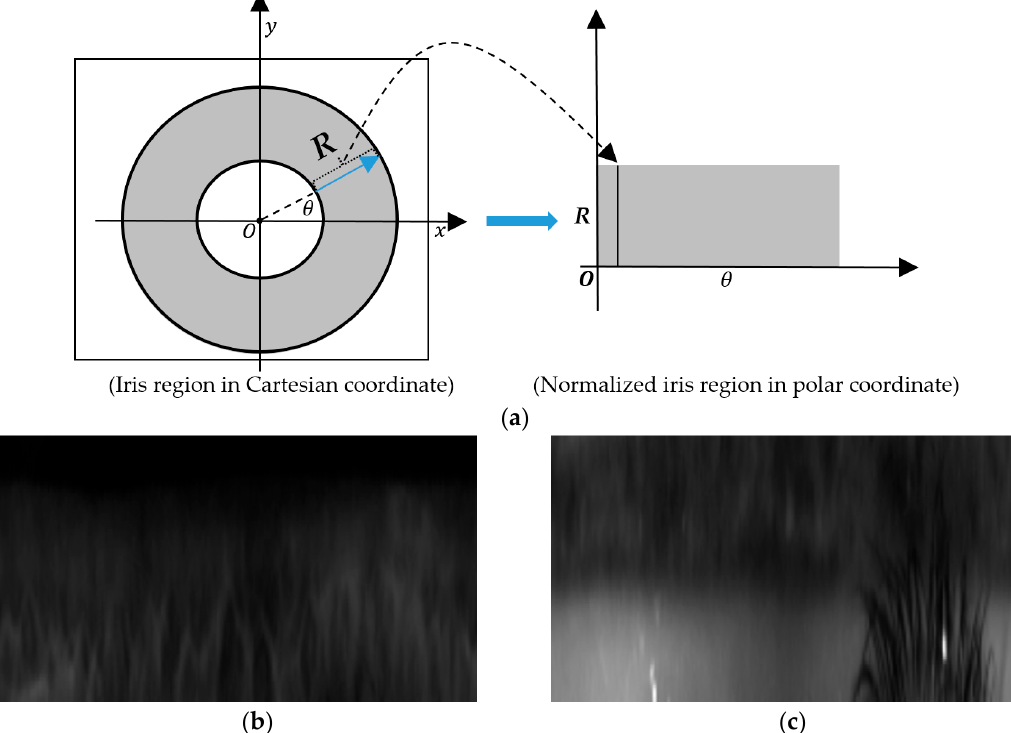
Figure 4. Normalization method of inner and outer iris regions: ( a ) normalization of iris region from Cartesian to polar coordinates, ( b ) normalized inner iris region of Figure 3a,c normalized outer iris region of Figure 3a.